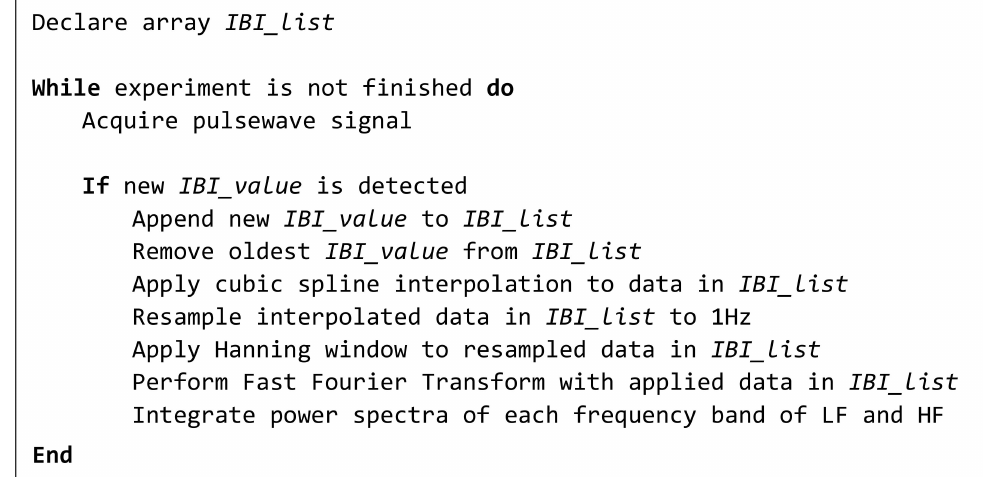
Figure 2. Pseudocode showing the calculation method of LF and